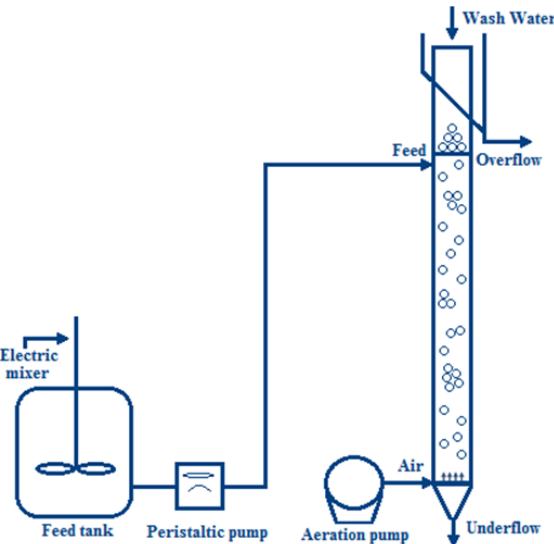
Fig. 1. A schematic illustration of the column flotation